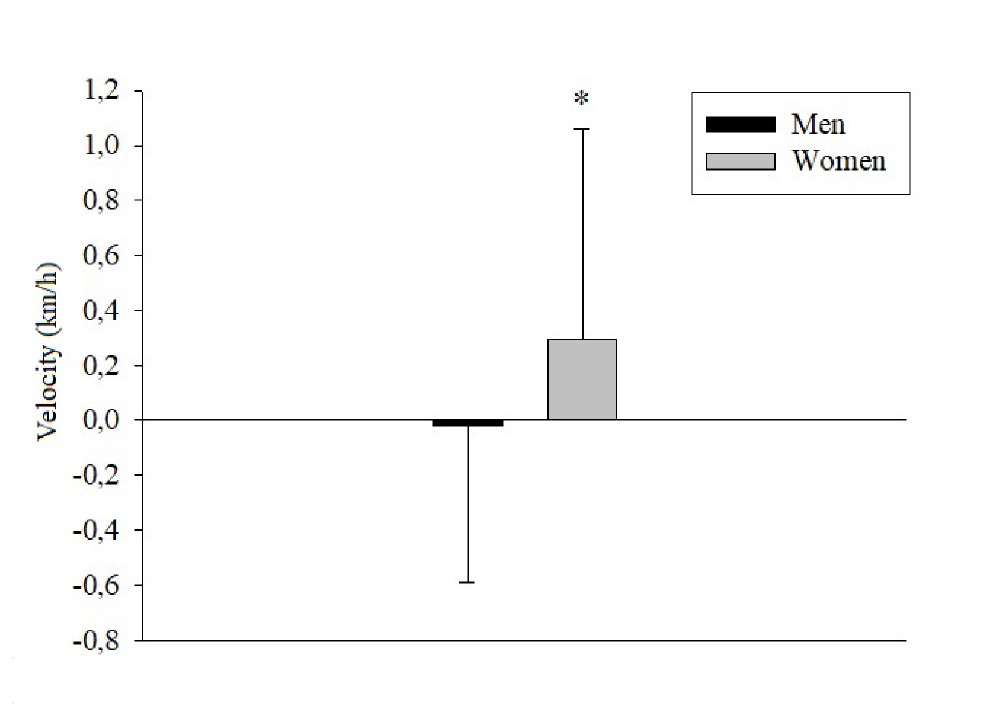
Figure 2 - General velocity variation from the male and female groups during the 10,000 race. (*) different from the male